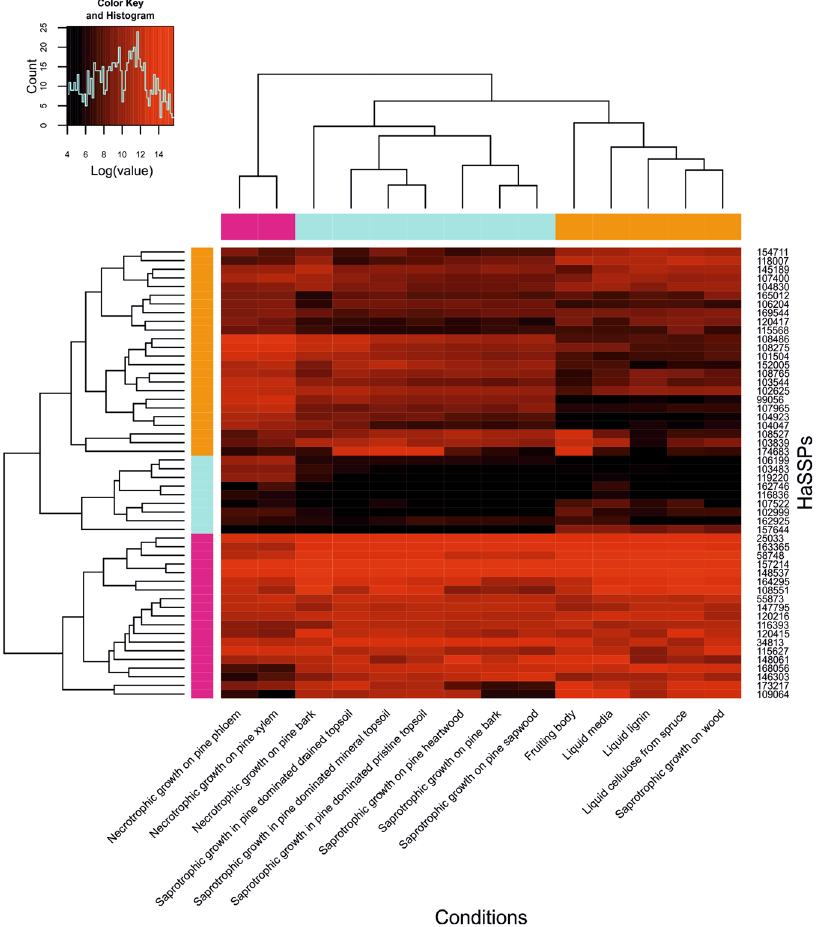
Figure 2. Microarray gene expression levels of the selected H. annosum small secreted protein (HaSSP) encoding genes in different conditions. Microarray data were retrieved from the Gene Expression Omnibus database (GEO) (https://www.ncbi.nlm.nih.gov/geo/). Raw data were normalized and analysed with the statistical R programme 48 using oligo 49 and gplots 50